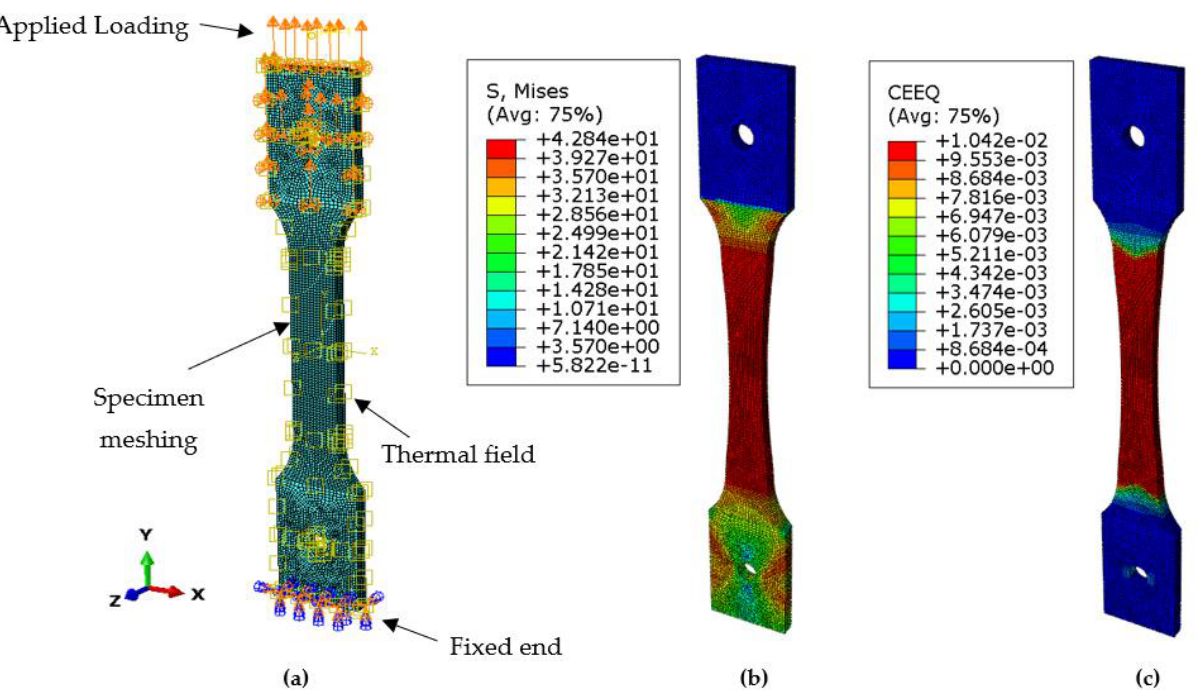
Figure 11. ( a ) FE model of specimen. ( b ) Induced Von Mises stress in the specimen after running simulation. ( c ) Creep strain (CEEQ) for the applied stresses.